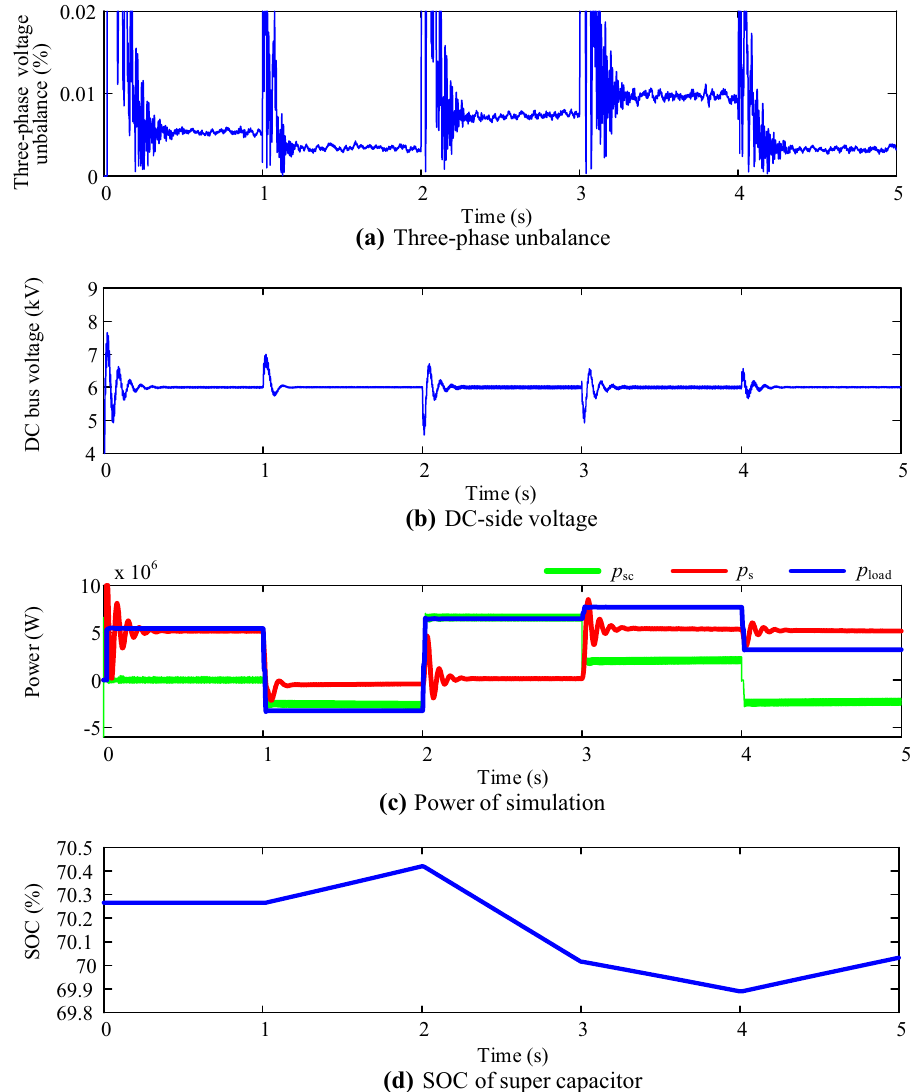
Fig. 14 Simulation results in traction, RB, peak shaving and valley filling conditions